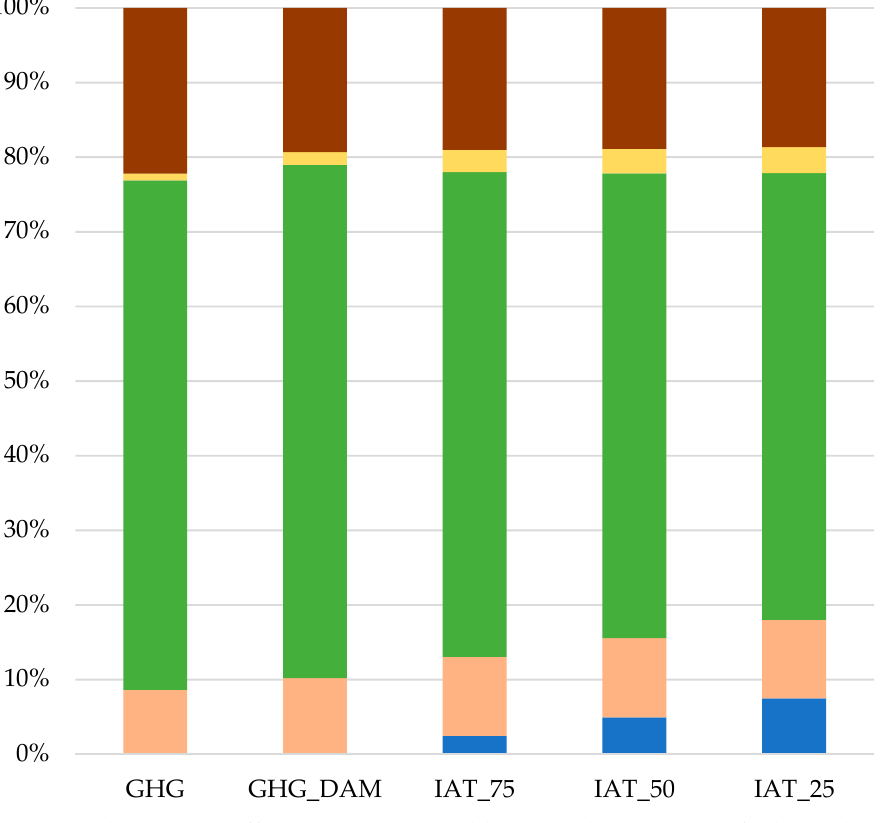
Figure 14. Shares of different mitigation options in CO 2 decomposition analysis compared to reference scenario in different scenarios in the EU28 in 2050.